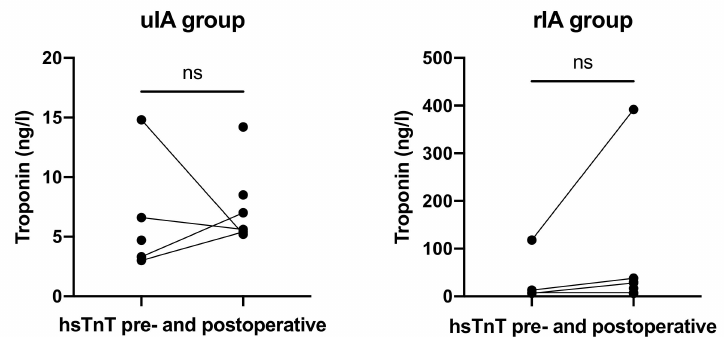
Figure 5. HsTnT levels before and after RVP did not differ in both groups. In the rIA group, values were available for 50% preoperatively and 100% postopera- tively. Mean preoperative hsTnT was 36.38 ng/L (range 6.6–118 ng/L) as compared with 65.75 ng/L (range 6.4–392 ng/L) postoperatively ( p =